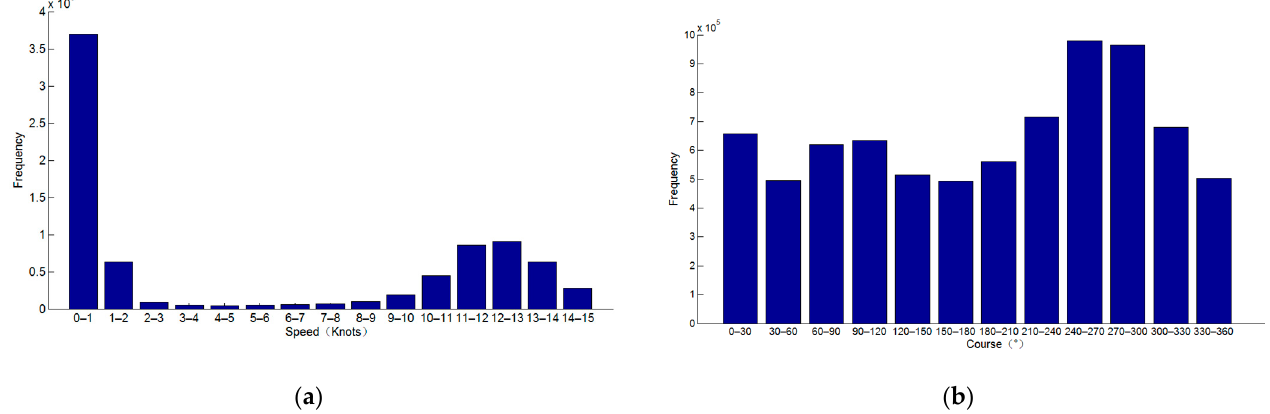
Figure 3. Interval distribution of speed and course: ( a ) Interval distribution of speed; ( b ) Interval distribution of course.